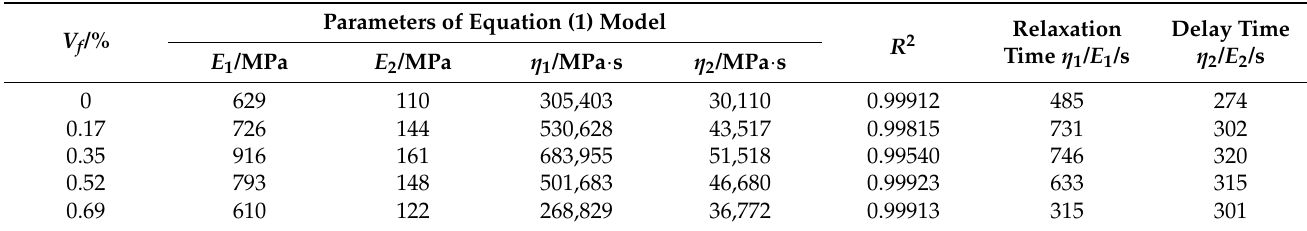
Table 2. Equation (1) model parameters of asphalt composite concrete with different V f